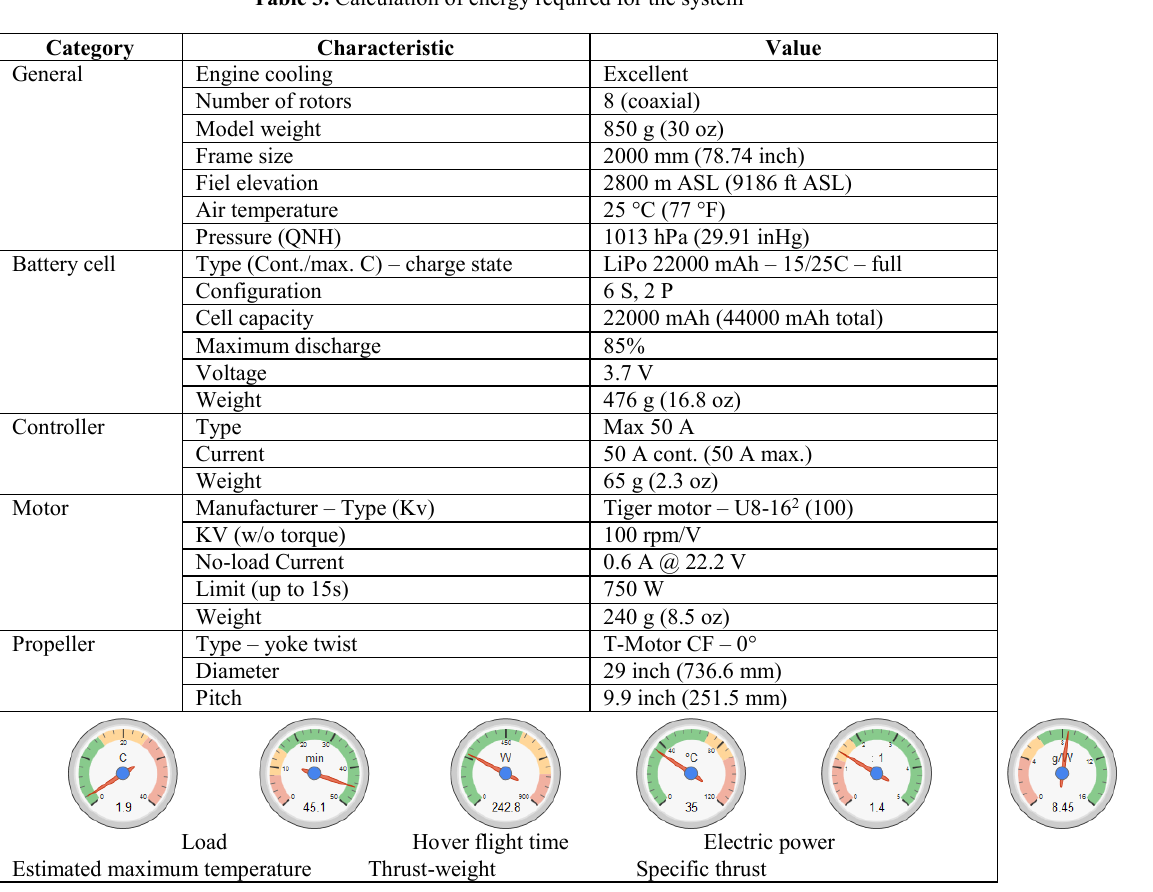
Table 3. Calculation of energy required for the